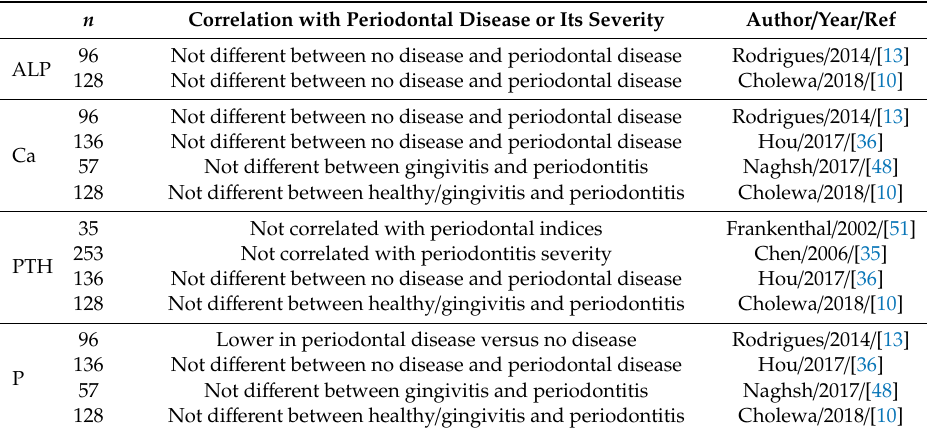
Table 4. Correlations of alkaline phosphatase, calcium, parathyroid hormone, and phosphorous with periodontal disease in patients receiving